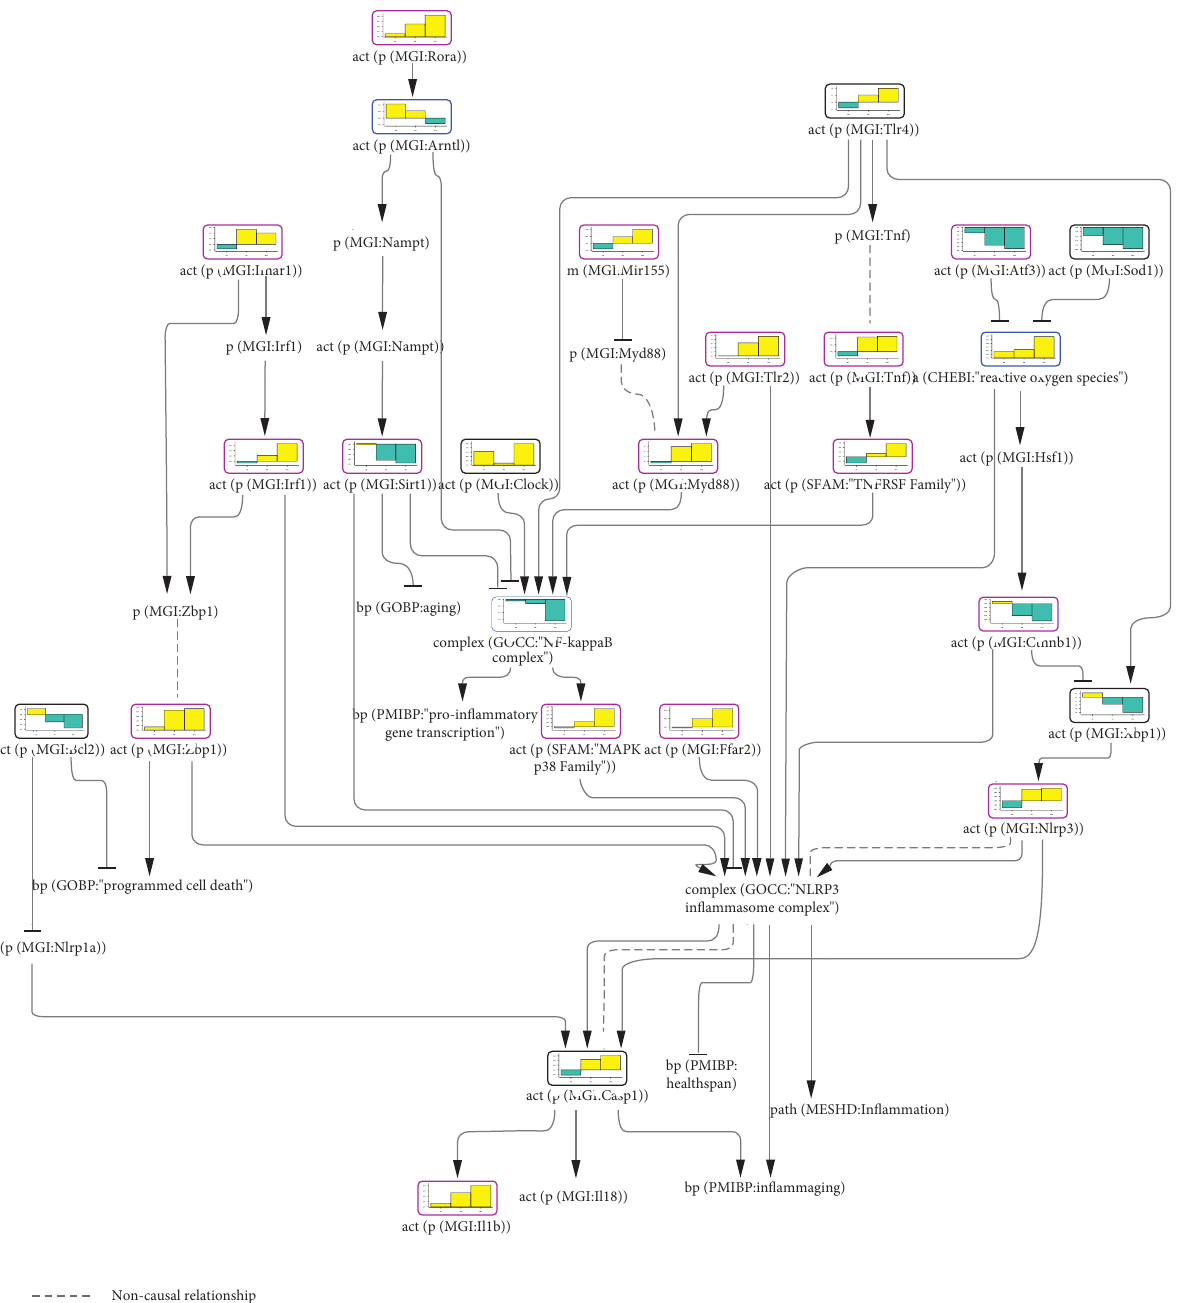
Figure 4: Part of the inflammasome network model scored with transcriptomic data from E-MEXP-839. The bar graph above each node, which was scored, shows the inferred fold change in the liver tissue of (1) 16-, (2) 96-, and (3) 130-week-old wild-type (WT) mice relative to 8-week-old WT mice. The directionalities are shown as yellow or blue bars for inferred upregulation or downregulation, respectively. The black outline refers to nodes that were significantly impacted in all ages, the purple outline refers to nodes that were significantly impacted at two time points, and the blue outline refers to nodes that were significantly impacted at only one time